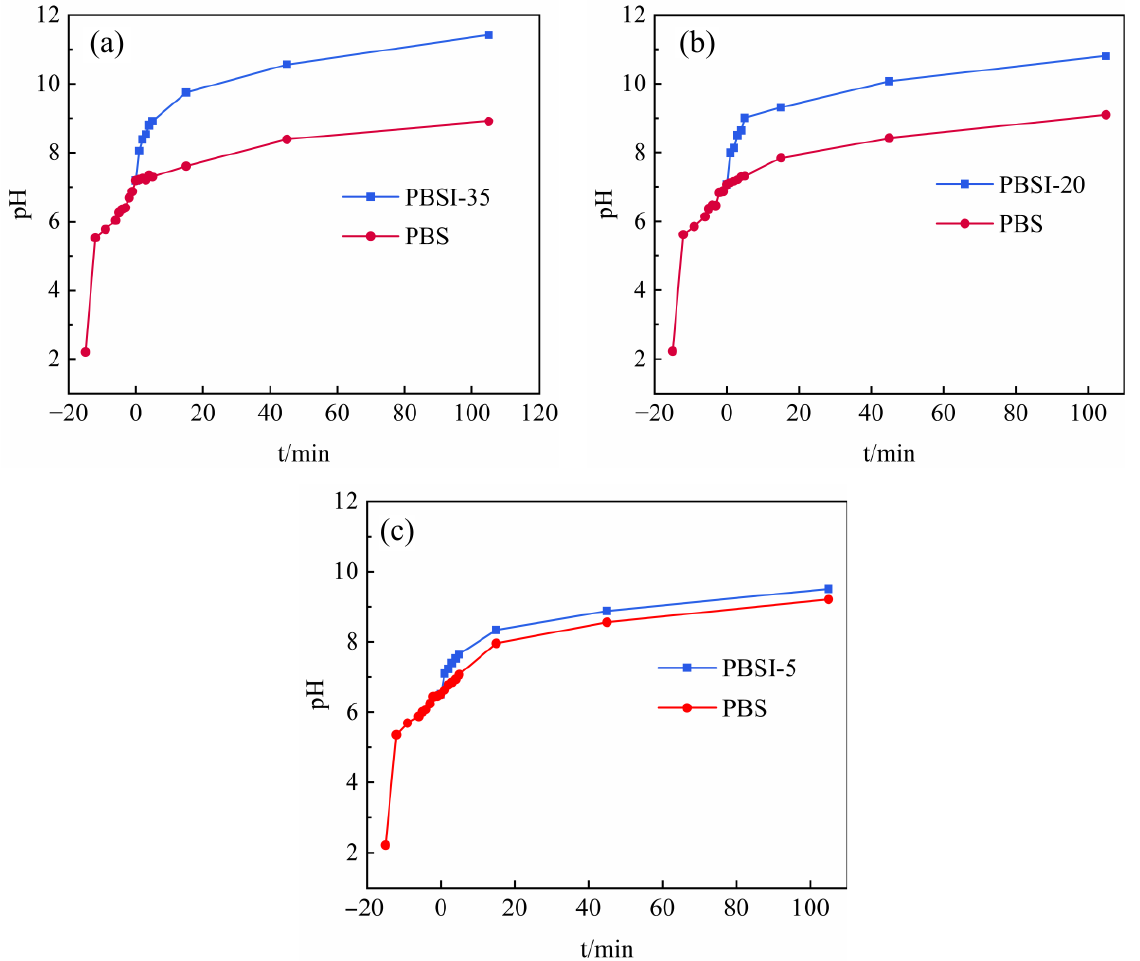
Figure 5. Changes in pH in backfill slurry with different amounts of ITs: ( a ) 35% ITs addition; ( b ) 20% ITs addition; and ( c ) 5% ITs addition.